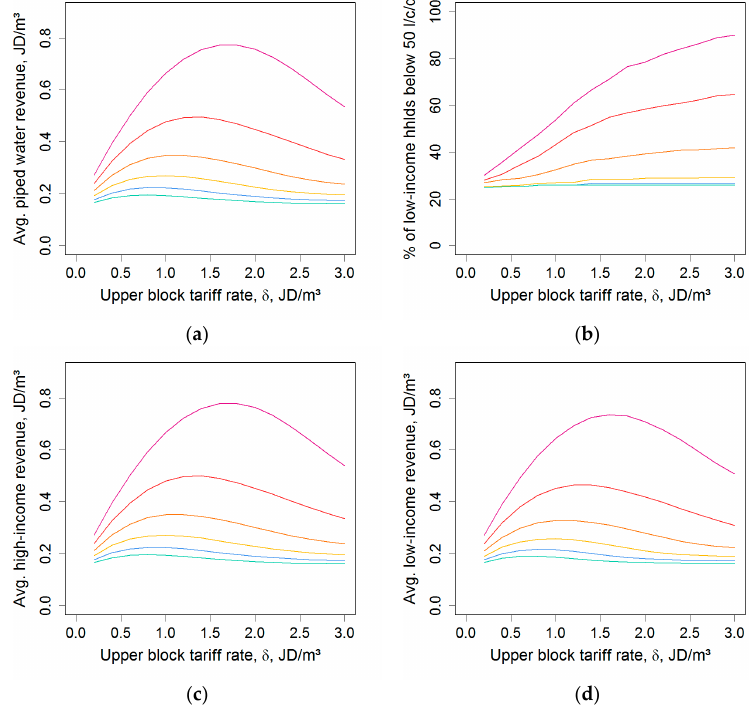
Figure 3. Results of simulation experiment 2, analyzing a two-block tariff consisting of one block free of charge, followed by a second block with a uniform tariff rate:, where the boundary between the two blocks is defined in m 3 per household per quarter: For various levels of the upper block tariff rate ( δ ) , ( a ) shows the average revenue per m 3 paid by all households; ( b ) shows the percentage of low-income households consuming less than 50 L per person per day; and ( c ) and ( d ) show the average revenue per m 3 paid by high and low income households, respectively. The colored curves indicate the following levels of the tariff increase threshold ( γ ) , measured in m 3 per household per quarter: pink = 20; red = 30; orange = 40; yellow = 50; blue = 60; green = 70. Axis labels: l/c/d = liters per capita per day; hhlds =